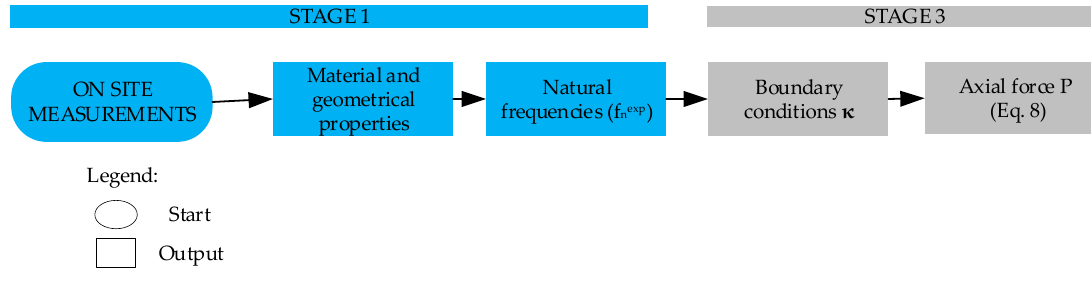
Figure 5. Methodology for axial load identification.